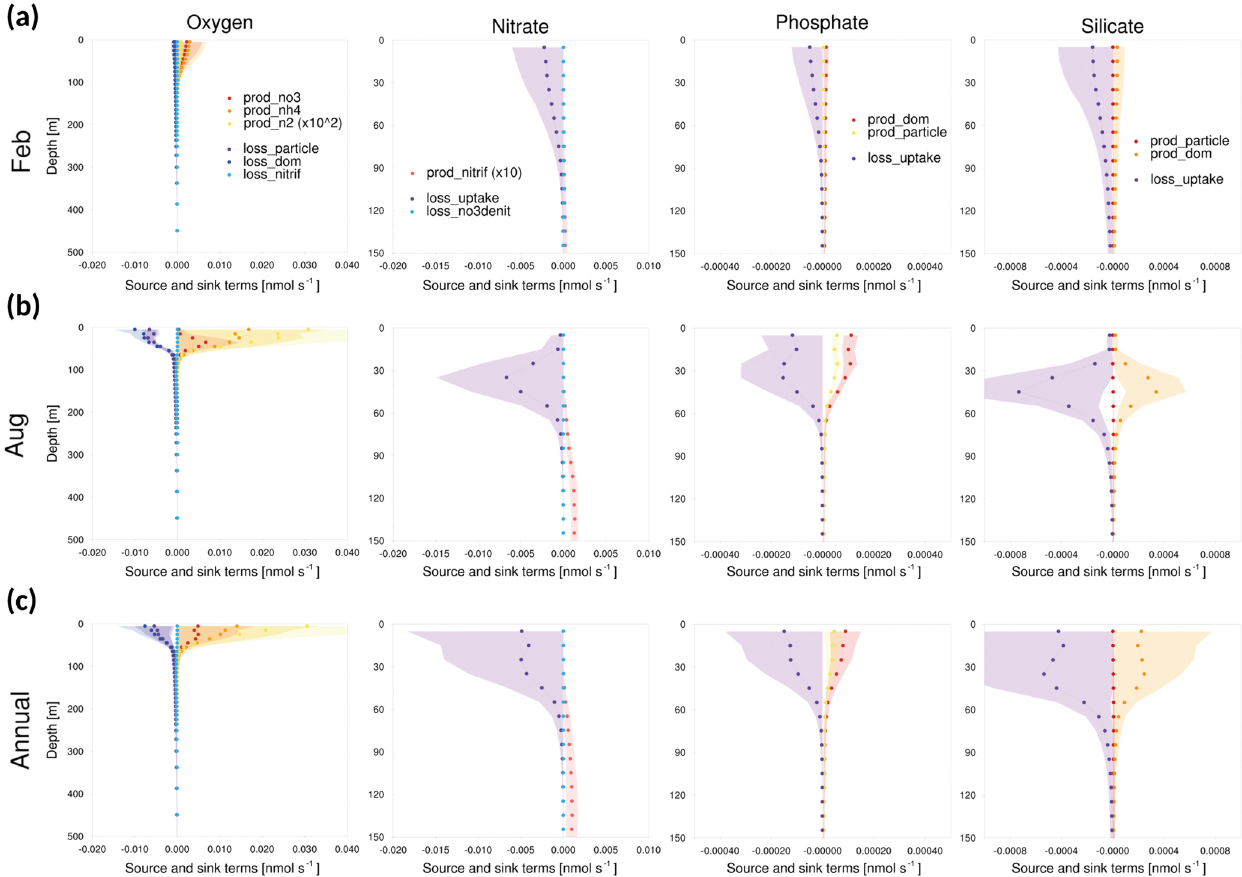
Figure 12. Vertical profiles of the tendencies of source and sink terms in GOTM–TOPAZ at point 104 for the 10-year period of 1999–2008, (a) for February, (b) for August, and (c) annually. The shaded areas represent 1 σ